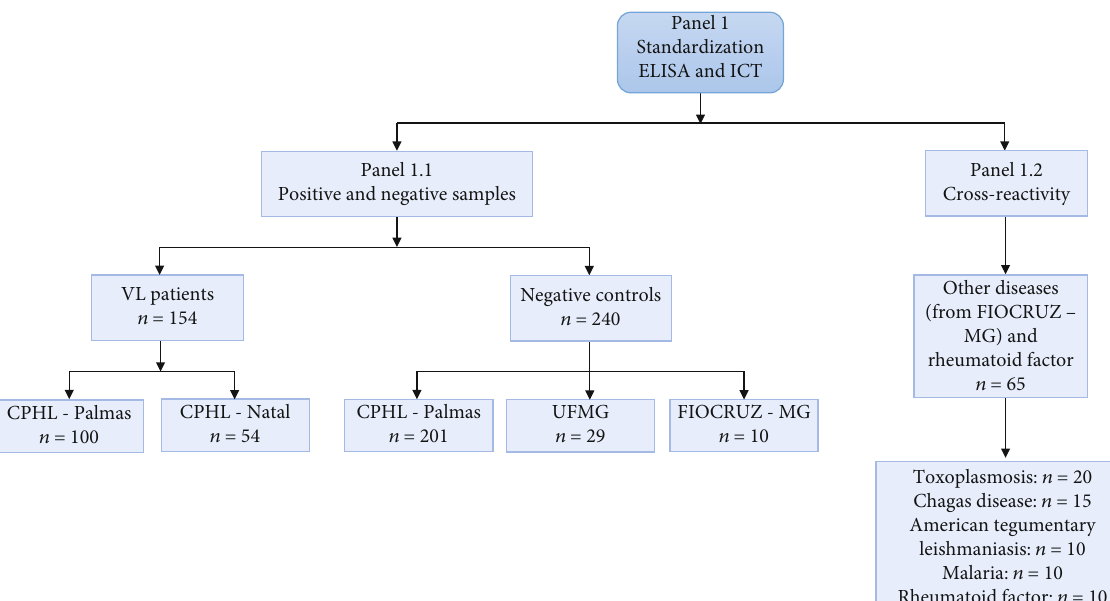
Figure 1: Sera samples used to standardize ELISA and ICT and the origin of the samples (panel 1.1 and panel 1.2). n : number of samples; VL: visceral leishmaniasis; CPHL-Palmas: Central Public Health Laboratory of Palmas (Tocantins State); CPHL-Natal: Central Public